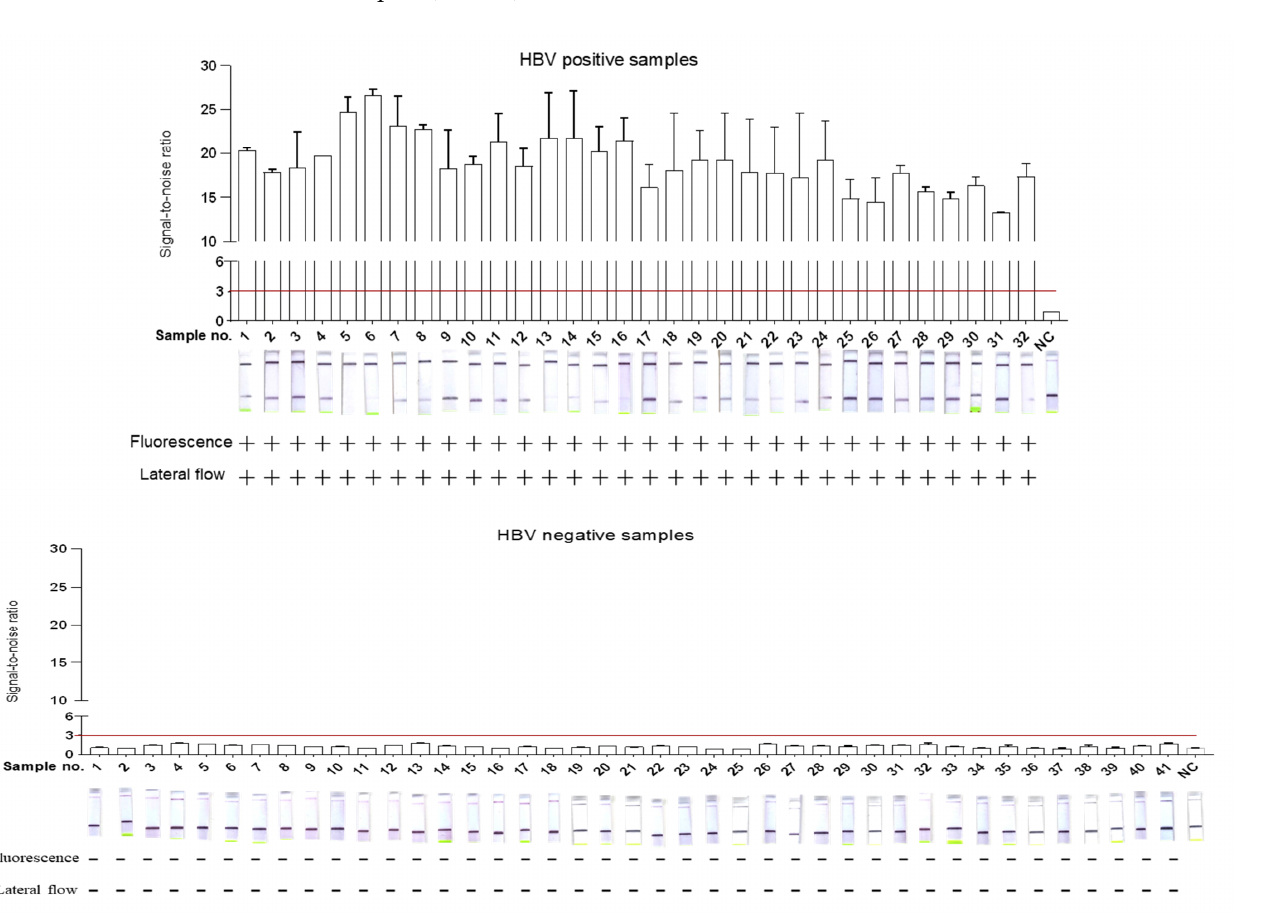
Figure 4. Cas12a-DETECTR assay for HBV in 73 clinical samples, which were tested using qPCR and Cas12a-DETECTR (including fluorescence readout and lateral flow test strip readout). Evaluation of Cas12a-DETECTR assay results with qPCR assay results. HBV positivity was defined based on qPCR results. +: indicates a positive sample, -: indicates a negative